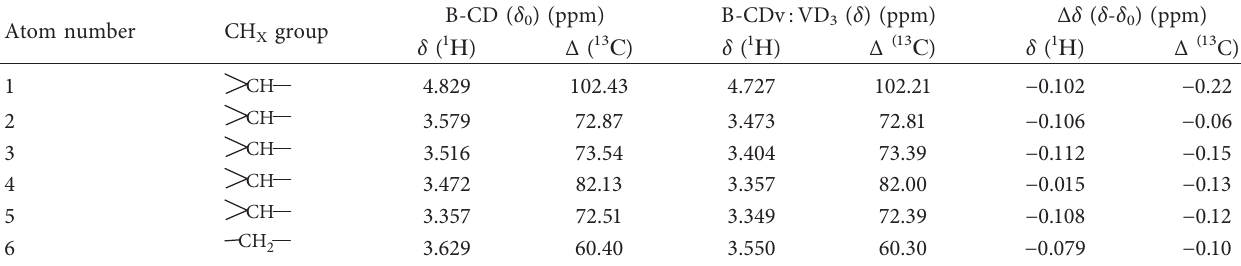
3 (2:1) inclusion